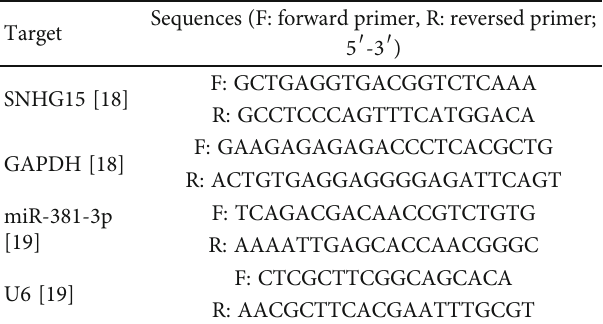
Table 1: Primer sequences.